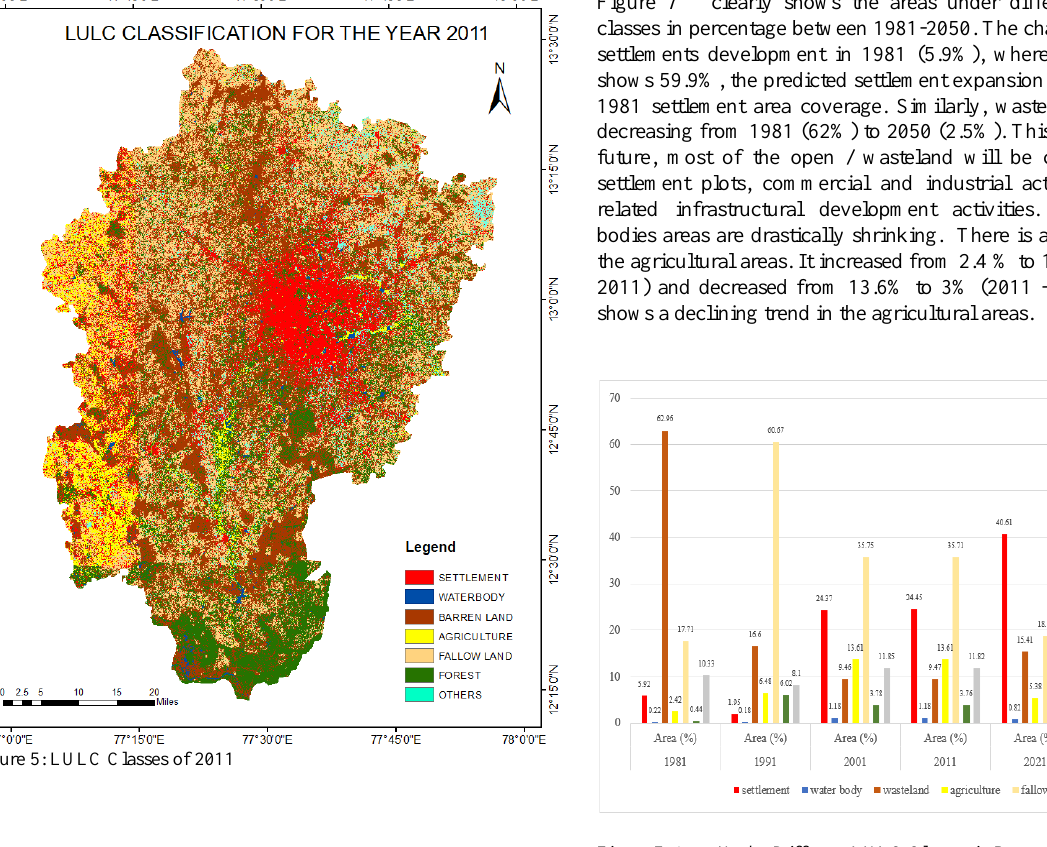
Figure 6: LULC Classes of 2021